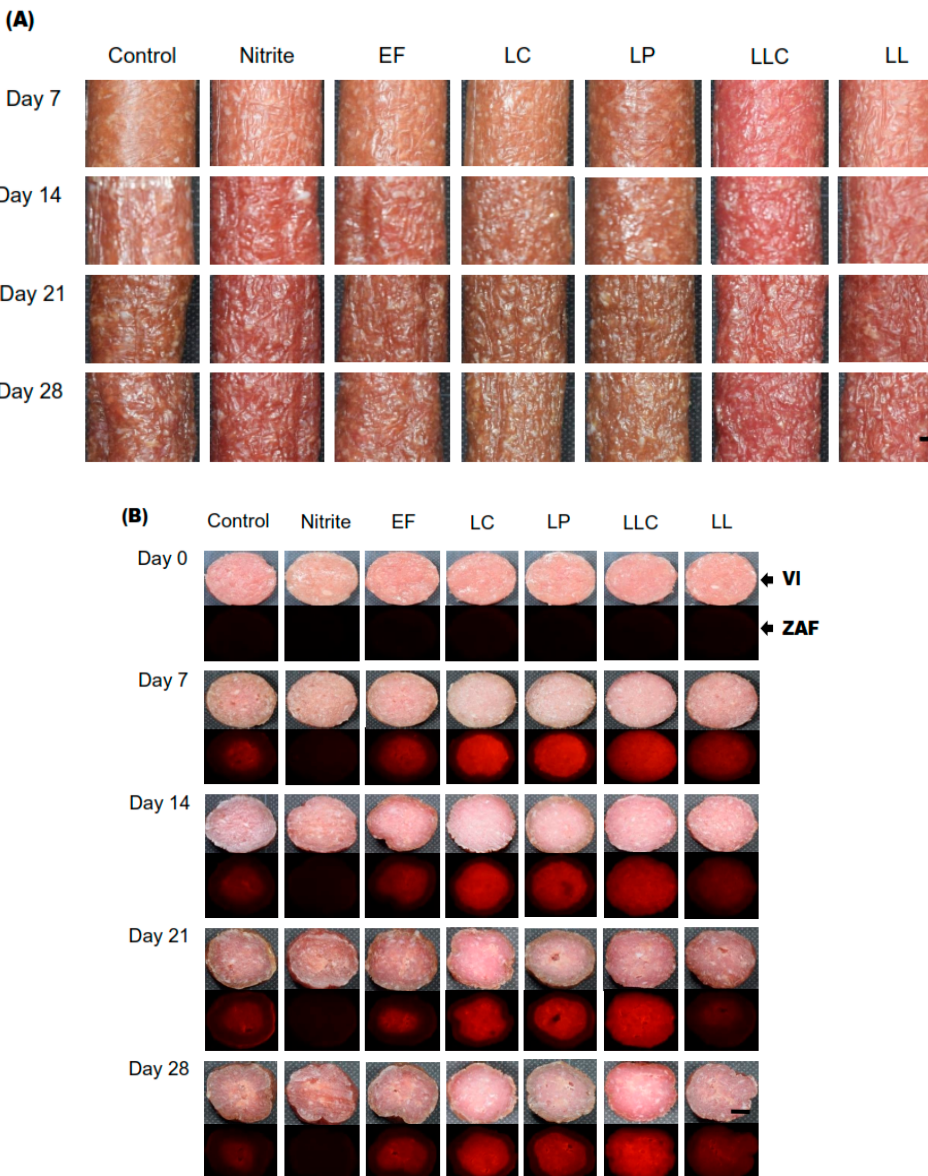
Figure 2. Effects of high ZnPP-forming LAB on the color of dry-cured fermented sausages. Dry-cured sausages inoculated with high ZnPP-forming LAB were ripened up to 28 days. Change in the color of the surface ( A ) and the internal color and ZnPP distribution ( B ) during processing. The upper ones are visual images (Vis) and the lower ones are ZnPP autofluorescence images (ZAFs), as indicated by arrows. Scale bars: 1 cm. ZnPP: zinc protoporphyrin IX, LAB: lactic acid bacteria, Vis: visual images, ZAFs: ZnPP autofluorescence images, EF: Enterococcus faecium , LC: Lactobacillus curvatus , LP: Lactobacillus plantarum , LLC: Lactococcus lactis subsp. cremoris , LL: Leuconostoc lactis.